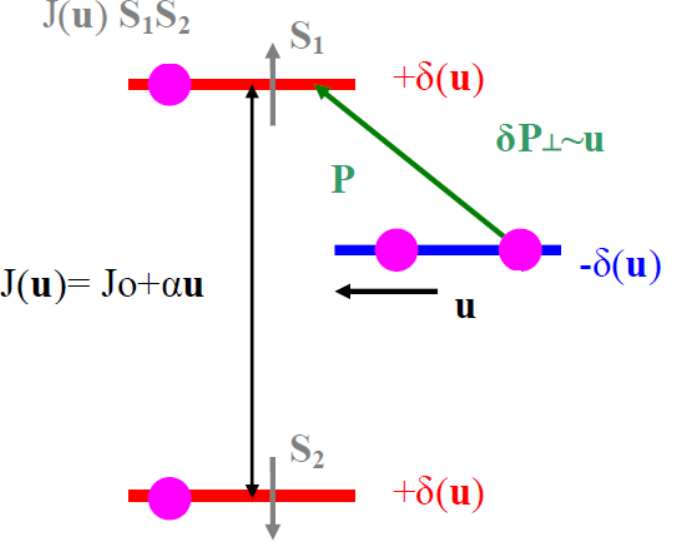
Figure 14. CO (of amplitude ±δ) and AF exchange coupling J S generalized distortion parameter u of the organic stack. The drawing represents the extreme δ = 0.5 situation where the HOMO of the donor is alternatively occupied by one electron (ionic donor D + ) and two electrons (neutral donor D 0 ). In the drawing the pink dots represent the electrons. The holes, corresponding to the absence of one electron on D + , bear the spins S and S . The exchange interaction J( u ) is tuned by the position, u , of the neutral 1 2 molecule which controls the intra-stack overlap of the HOMO’s. The figure shows also that the molecular shift u changes the orientation of the electric dipole P of the D 0 D +